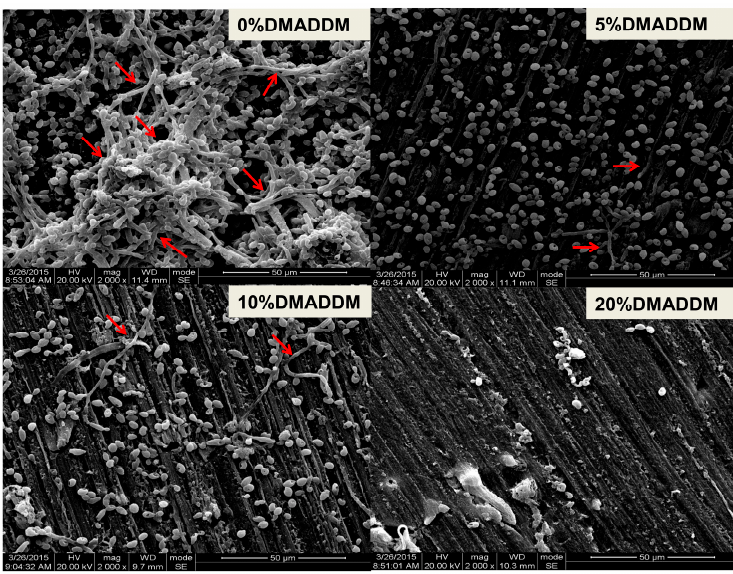
Figure 7. Scanning electron microscope (SEM) images of C. albicans biofilms. The red arrows indicate the hyphal form of C. albicans .